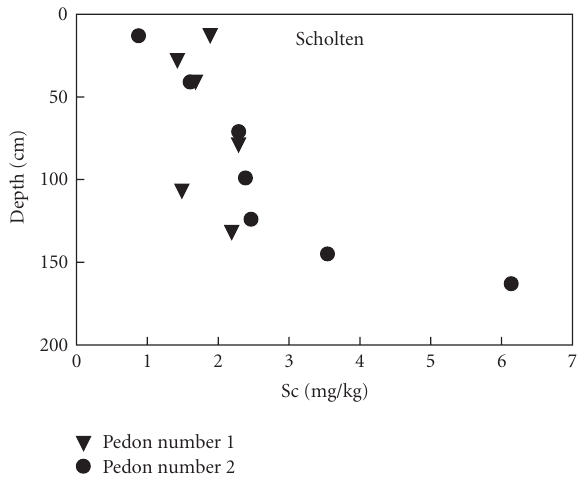
Figure 4: Soil profile Sc depth distribution for the Scholten (Fragiudults) pedons.